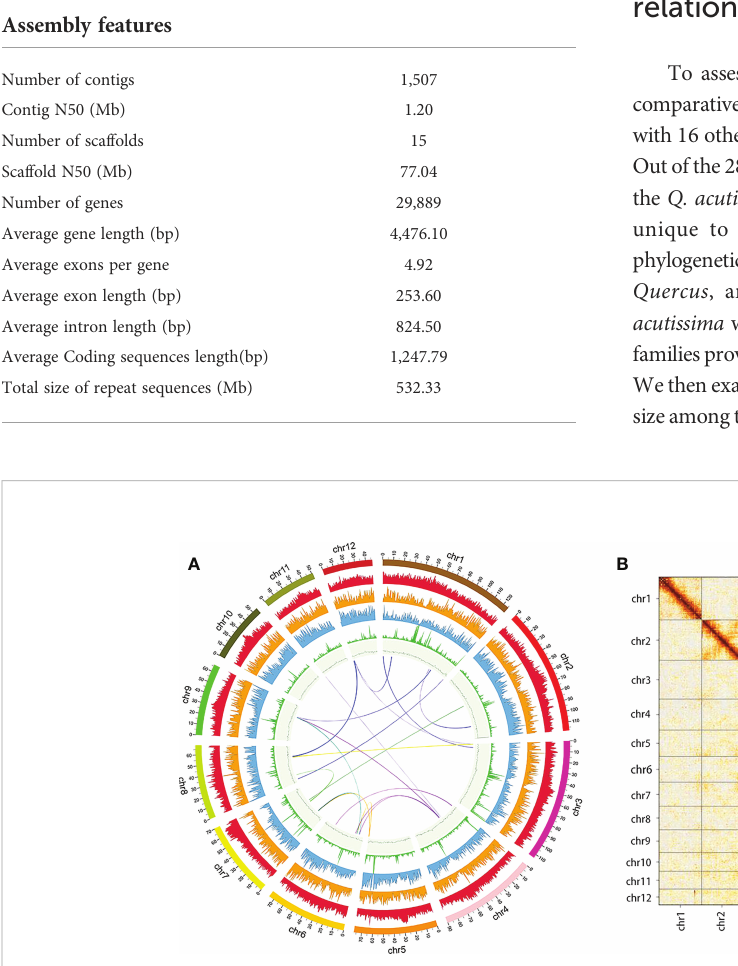
TABLE 1 Quercus acutissima genome assembly